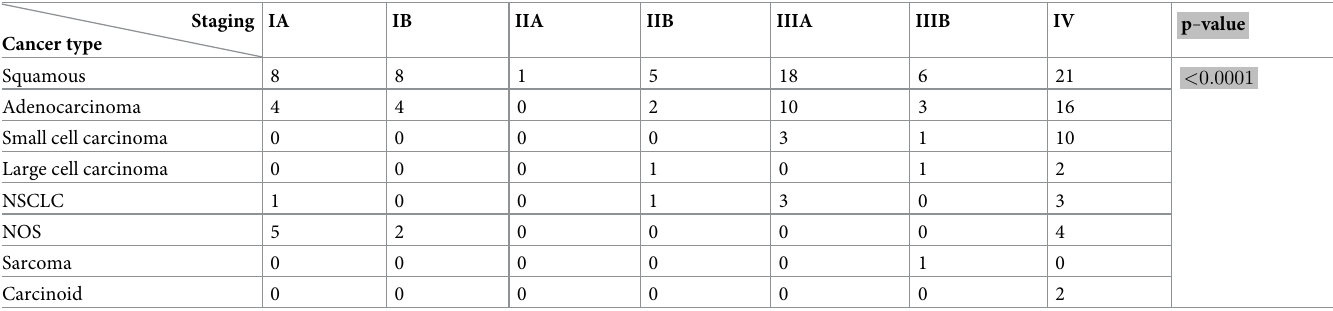
Table 2. Number of patients per histologic type of cancer and clinical staging. Staging Cancer